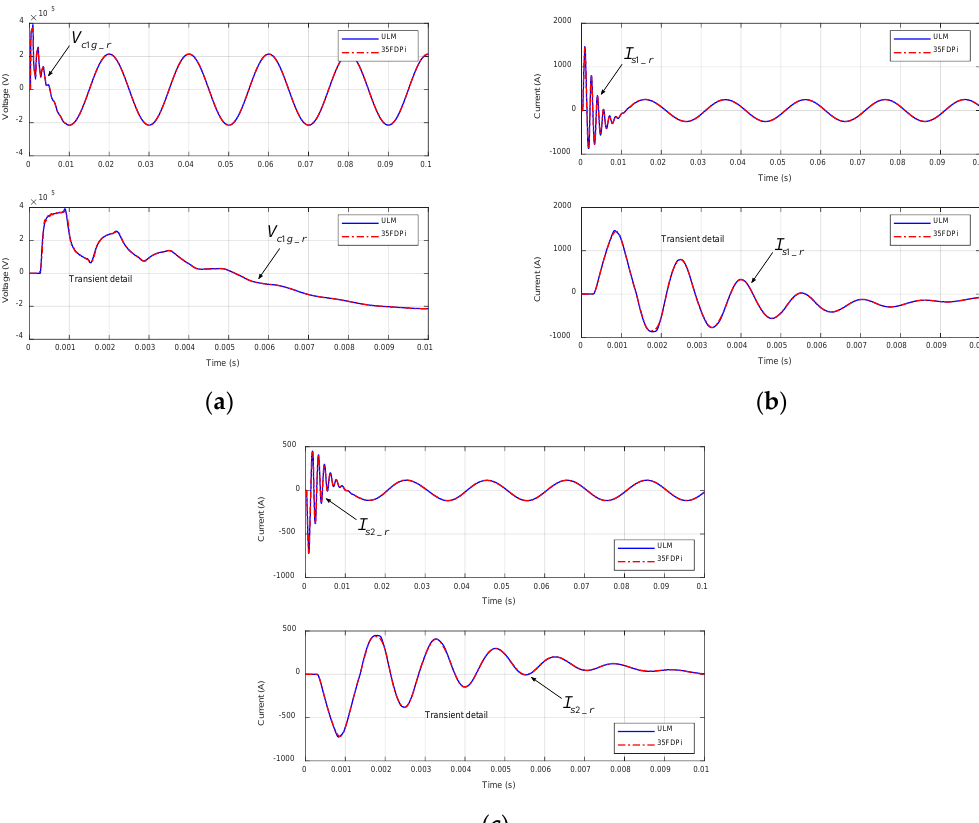
Figure 12. Time response comparison for Case Study #2. ( a ) V c1g_r . ( b ) I s1_r . ( c ) I s2_r .